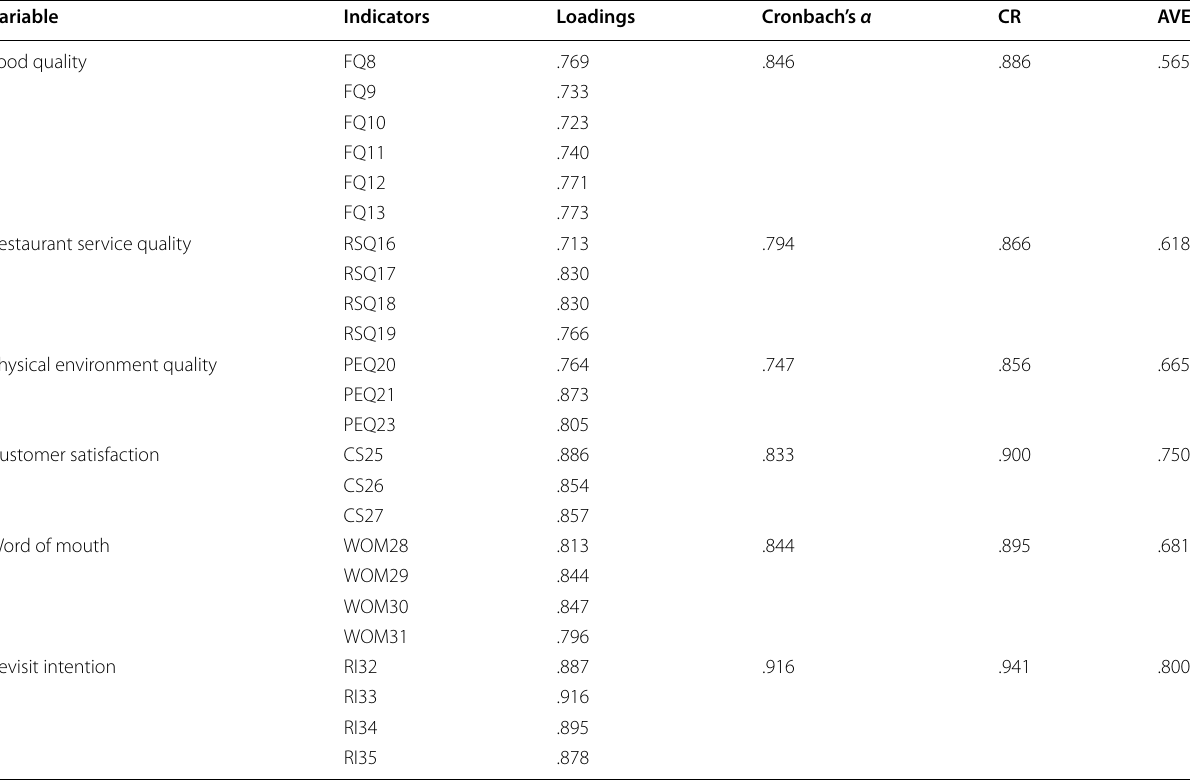
Table 2 Construct reliability and results of outer model Variable